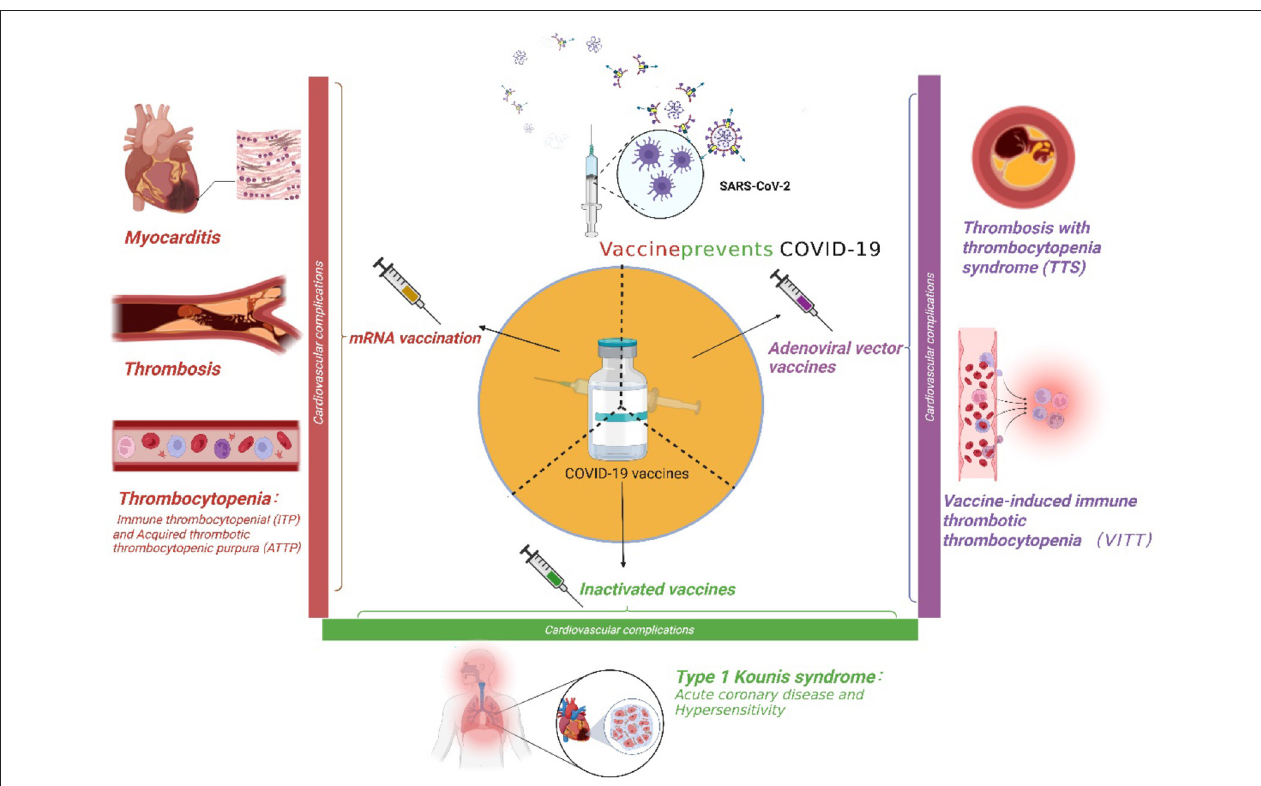
FIGURE 1 | The cardiovascular complications of three major coronavirus disease 2019 (COVID-19)